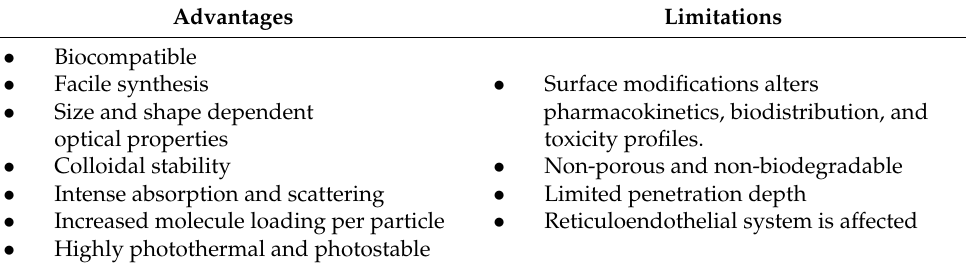
Table 3. Advantages and limitations of GNPs in cancer treatment